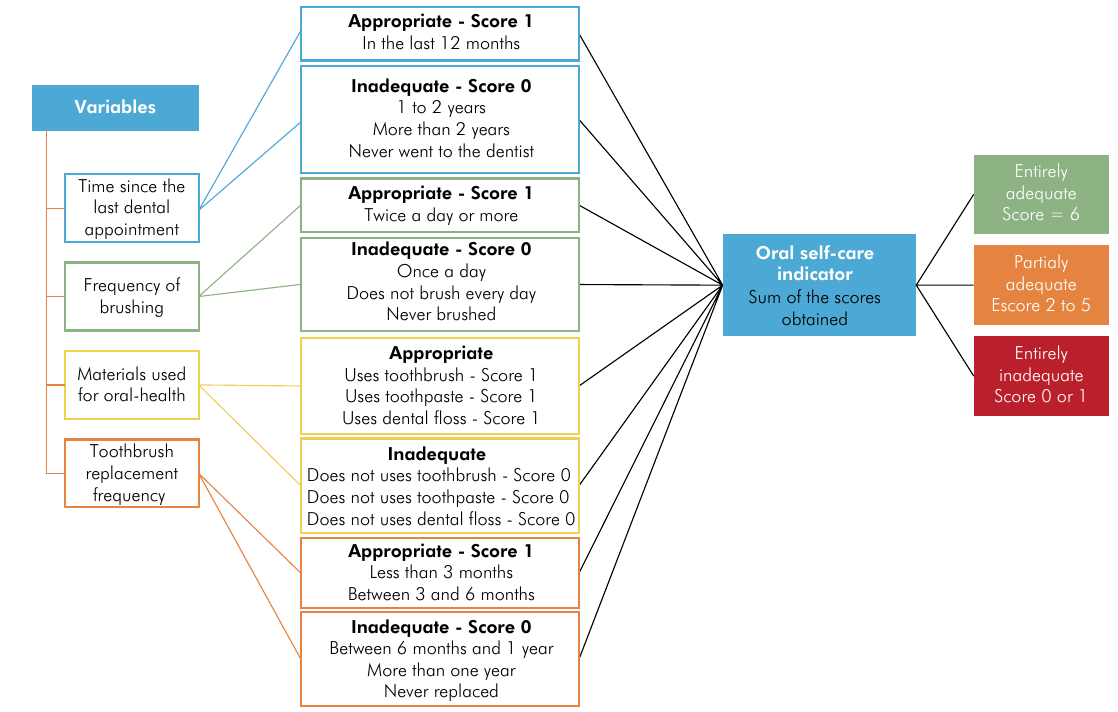
Figure 1. Process of forming the dependent variable of ‘oral